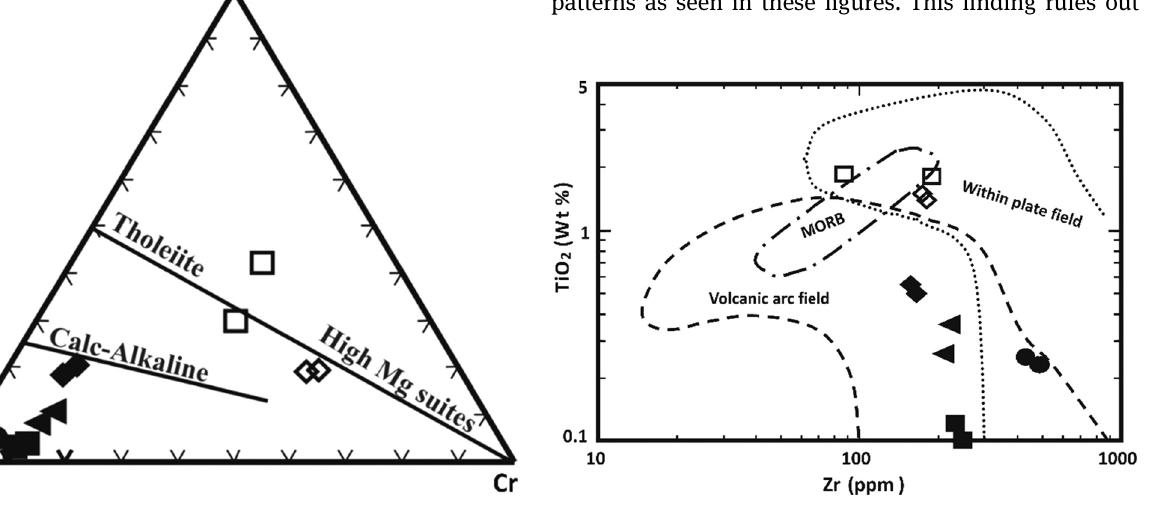
Figure 8: Y + Zr - TiO 2 *100 – Cr ternary diagram for di ff erent dikes, after Davies et al. [ 27 ] ; symbols as in Figure 4.